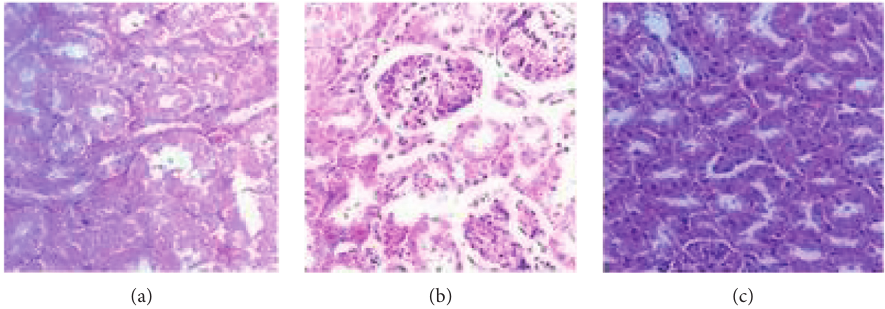
Figure 6: Photomicrographs of the kidney sections of rat. (a) Control. (b) A. malaccensis 300mg/kg. (c) A. malaccensis 2000mg/kg. Scale bar, 10 µ